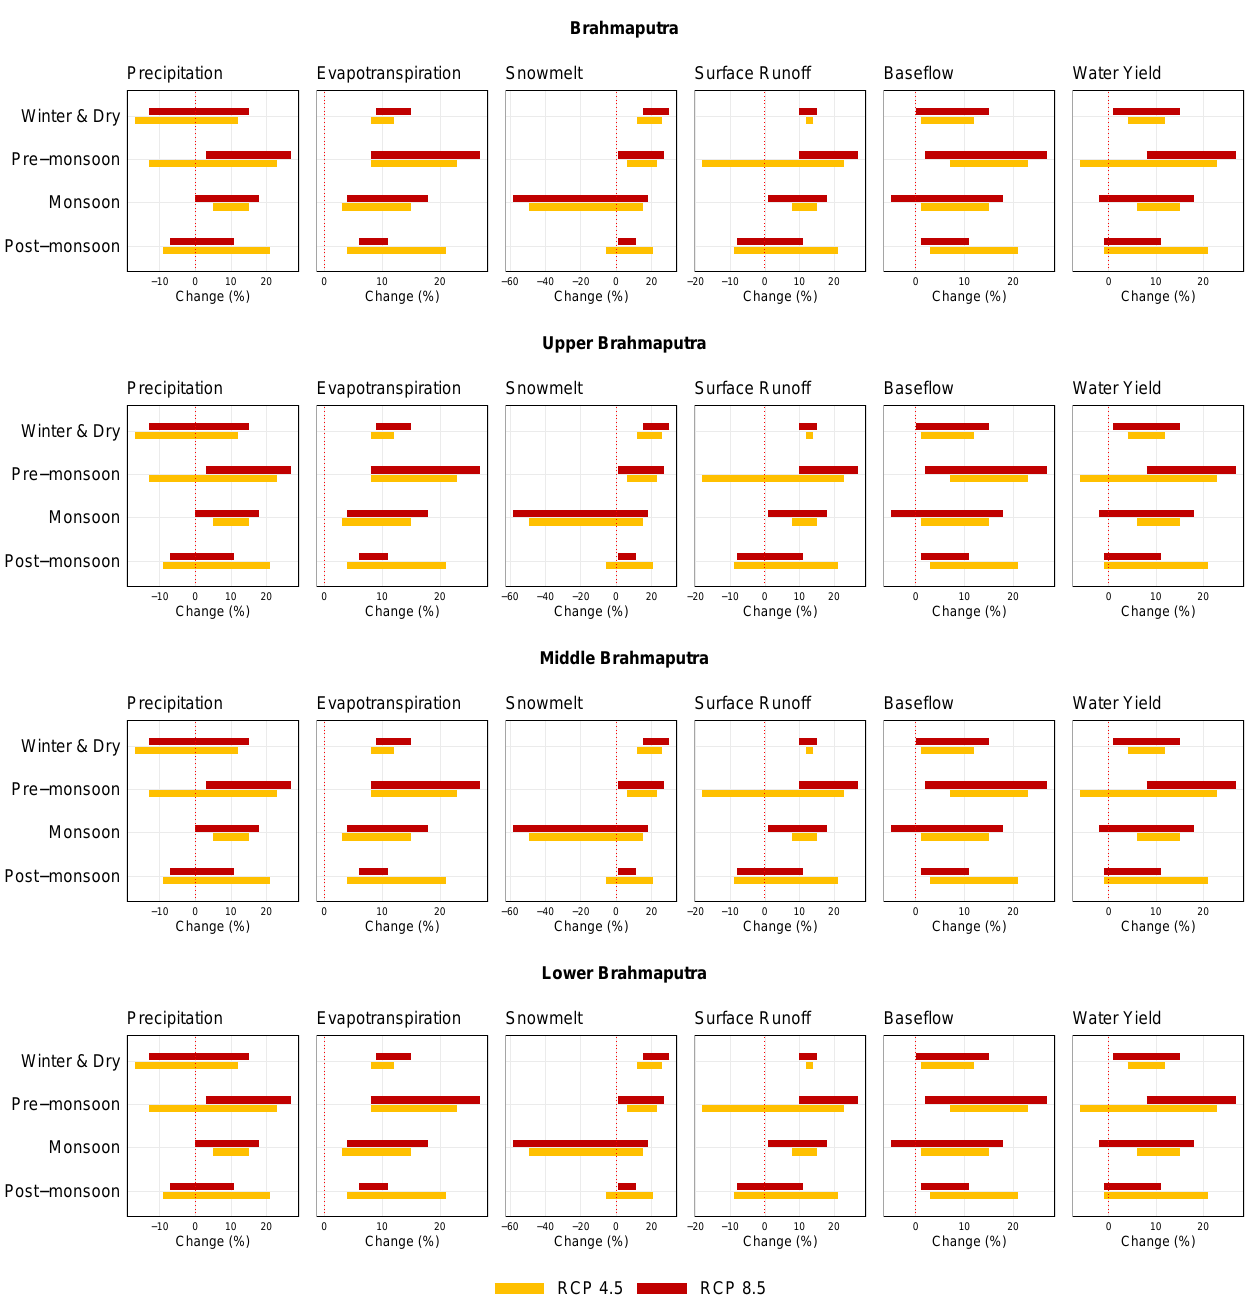
Figure 14. Seasonal maximum and minimum percentage changes in key water balance components for the entire Brahmaputra basin and its three major regions (Upper, Middle and Lower) under RCP4.5 and RCP8.5 scenarios. For each RCP, maximum and minimum ranges are based on four climatic